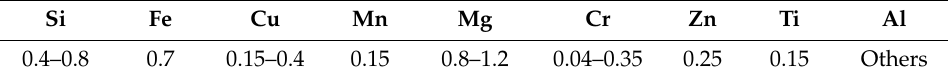
Table A2. Composition of the Al6061 material used in this study (unit: